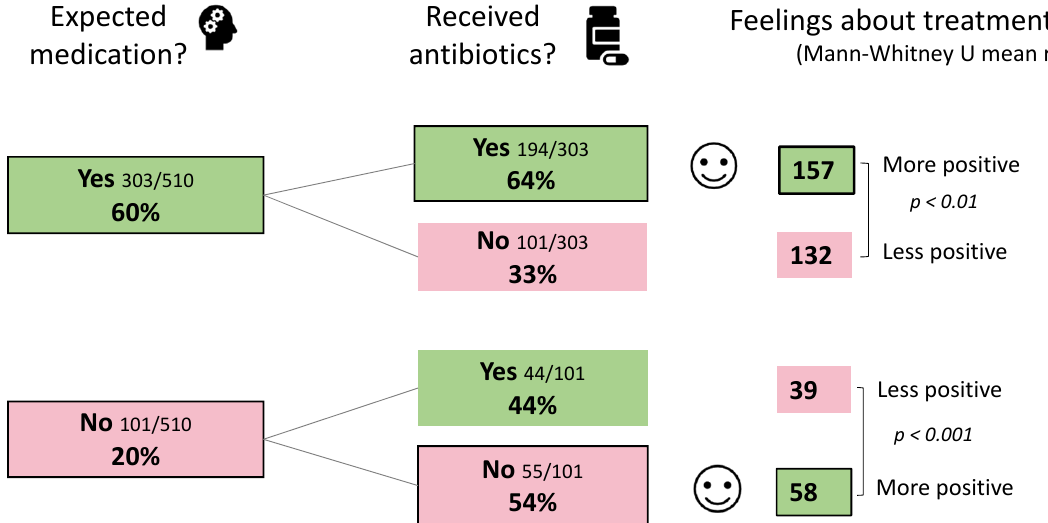
Figure 4. Owner feelings about treatment decision, based on their expectations about medication for their pet and whether they received antibiotics. ‘Unsure’ responses were removed, therefore totals are